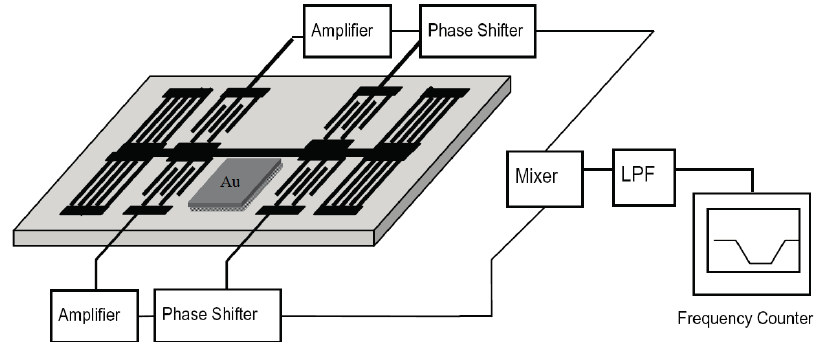
Figure 2. The oscillator circuit